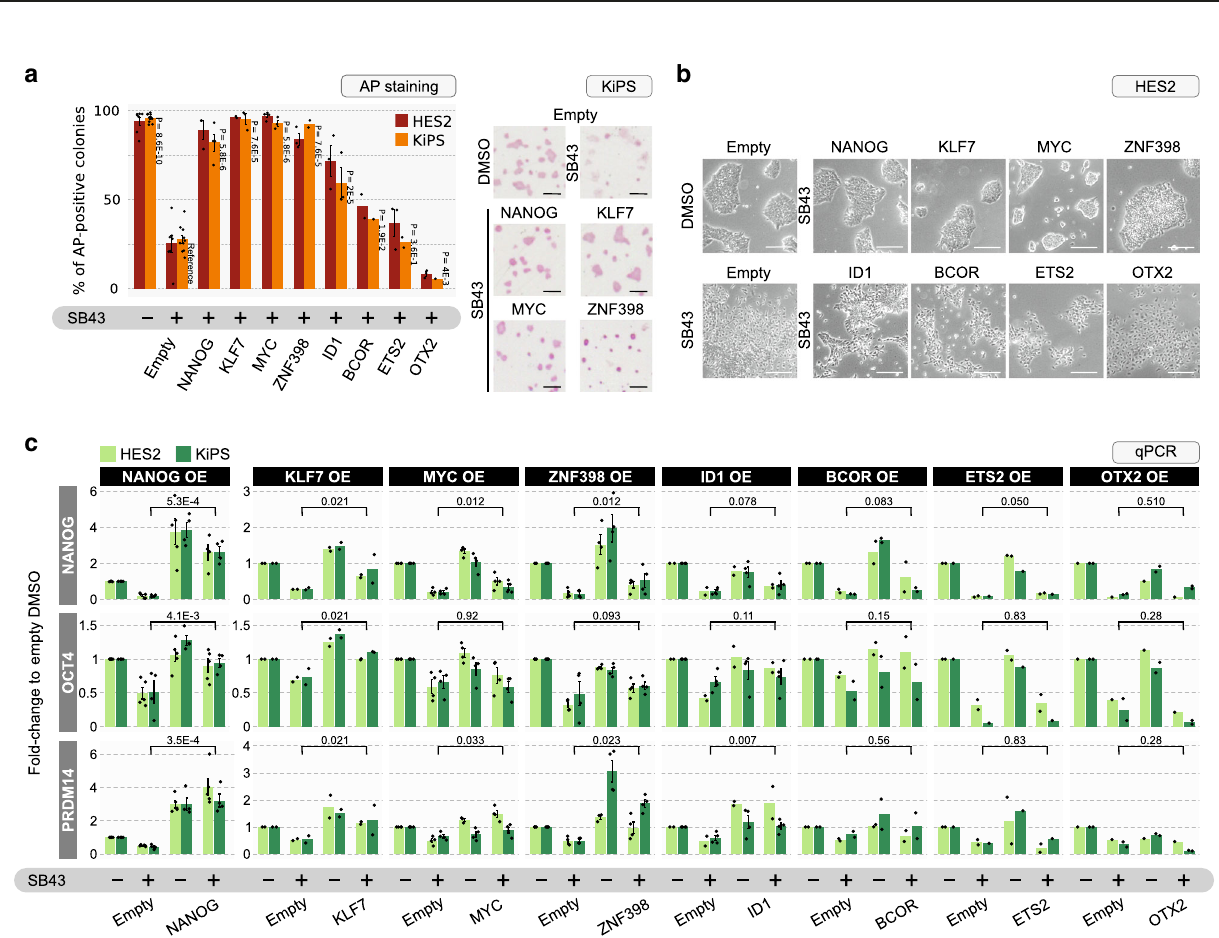
Fig. 2 Validation of TGF-beta transcriptional targets. a Balloon plot summarising validation experiments. Balloon size indicates the statistical signi fi cance, colour indicates the fold-change in expression relative to DMSO-treated hPSCs. Left: Microarray data as in top panel of Fig. 1d were independently validated by qPCR. Validation experiments were performed in two different culture conditions: feeder-free or on feeders (MEF). Expression was normalised to the mean of DMSO-treated cells. Right: RNA-seq data as in bottom panel of Fig. 1d were independently validated by qPCR. Expression was normalised to the mean of SB43-treated samples. The grey box highlights the known direct targets of SMAD3 (positive controls, including SKIL, one of the 21 candidates). Transcriptional SMAD3 targets independently con fi rmed are highlighted in bold. For qPCR validation, fi ve independent experiments were performed for each condition. Unpaired two-tailed t -test, p -values were not adjusted. See also Supplementary Fig. 1f, g. Source data are provided as a Source Data fi le. b Example of SMAD3 binding and gene expression analysis of three validated targets. Top: Gene tracks represent binding of SMAD3 (data from ref. 15 ) at the indicated gene loci. Red lines indicate the regions validated by ChIP-qPCR. Center: ChIP-qPCR on SMAD7, NANOG and ZNF398 loci was performed using anti-SMAD3 and anti-SMAD2 or a rabbit control IgG antibody in BG01V (dark grey) and H9 (light grey) cell lines. Enrichment is expressed as a percentage of the DNA inputs. Bars indicate the mean of two biological replicates shown as dots. Bottom: Gene expression analysis by qPCR. Bars indicate mean ± SEM of n = 7, 7, 5, 7, 9, 10, 8, 6 biological replicates over six independent experiments shown as dots for SMAD7, n = 7, 6, 5, 6, 5, 5, 5, 5 biological replicates over fi ve independent experiments shown as dots for NANOG, and n = 8, 7, 5, 6, 9, 10, 8, 6 biological replicates over six independent experiments shown as dots for ZNF398. Expression was normalised to the mean of SB43 16 h samples. Unpaired two-tailed t -test. Source data are provided as a Source Data fi le.